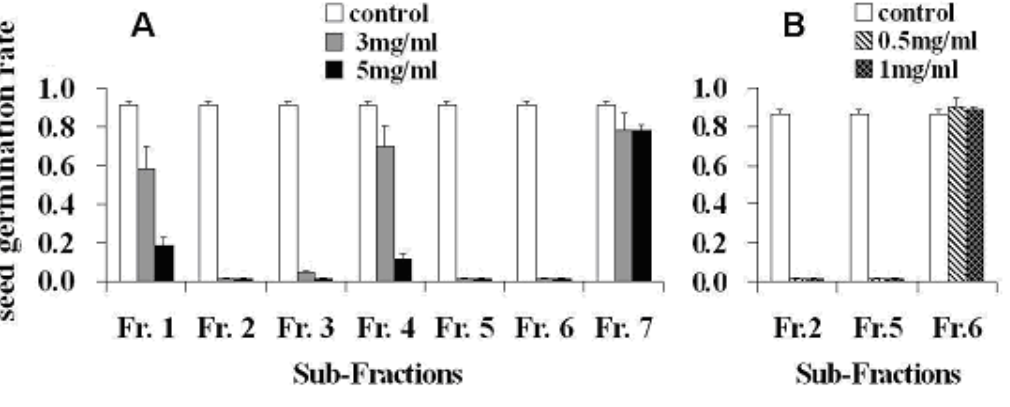
Figure 2. Arabidopsis seed germination rates recorded after three days in Hoagland medium containing sub-fractions (Fr.1-Fr.7) of the acetone extract of the plant fresh tissues at the indicated concentrations or nothing (A: bioactive assay for all seven sub-fractions at 3.0 and 5.0 mg/mL concentrations; B: further bioactive assay for Fr.2, Fr.5 and Fr.6 at 0.5 and 1.0 mg/mL concentrations; control: filter paper treated with 3 mL of pure acetone). Values are means ± s.d. from three independent experiments (30 seeds per treatments). Seeds germination rate ＝ (number of germinated seeds/30) ×